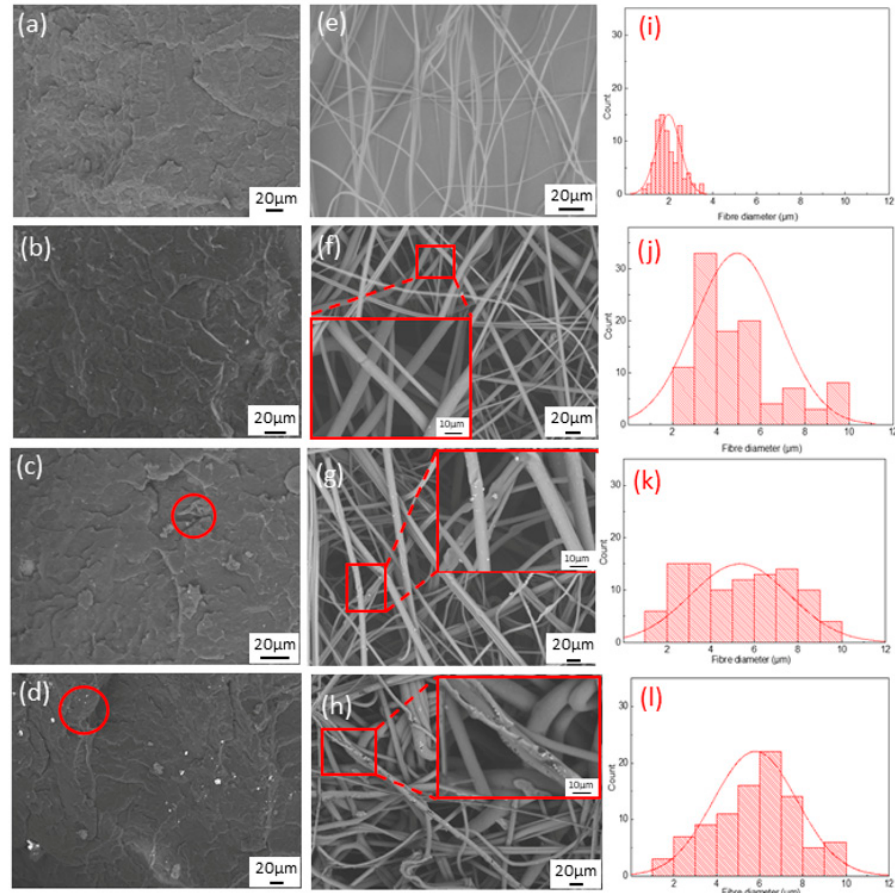
Figure3. ThefracturesurfacesofPP / TiO 2 hot-pressfilm( a )F-PP / TiO 2 -0, ( b )F-PP / TiO2-1, ( c )F-PP / TiO 2 -3, ( d ) F-PP / TiO 2 -5; the SEM images of PP / TiO 2 melt-blown membranes ( e ) M-PP / TiO 2 -0, ( f ) M-PP / TiO 2 -1, ( g ) M-PP / TiO 2 -3 ( h ) M-PP / TiO 2 -5, and the fiber diameter of PP / TiO 2 nonwovens ( i ) M-PP / TiO 2 -0, ( j ) M-PP / TiO 2 -1, ( k ) M-PP / TiO2-3, and ( l ) M-PP / TiO 2 -5. Table 4. Diameter distribution of melt-blown membranes as related to the content of TiO 2 .